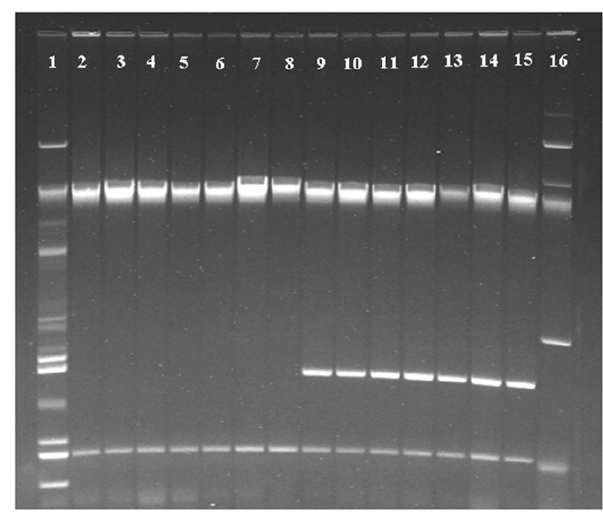
Figure 1. Plasmid profiles of 14 of the 30 Salmonella Kentucky isolates from commercial layer poultry farms in Bangladesh, isolates: 30 Salmonella Kentucky and 60 non-serotyped were investi-